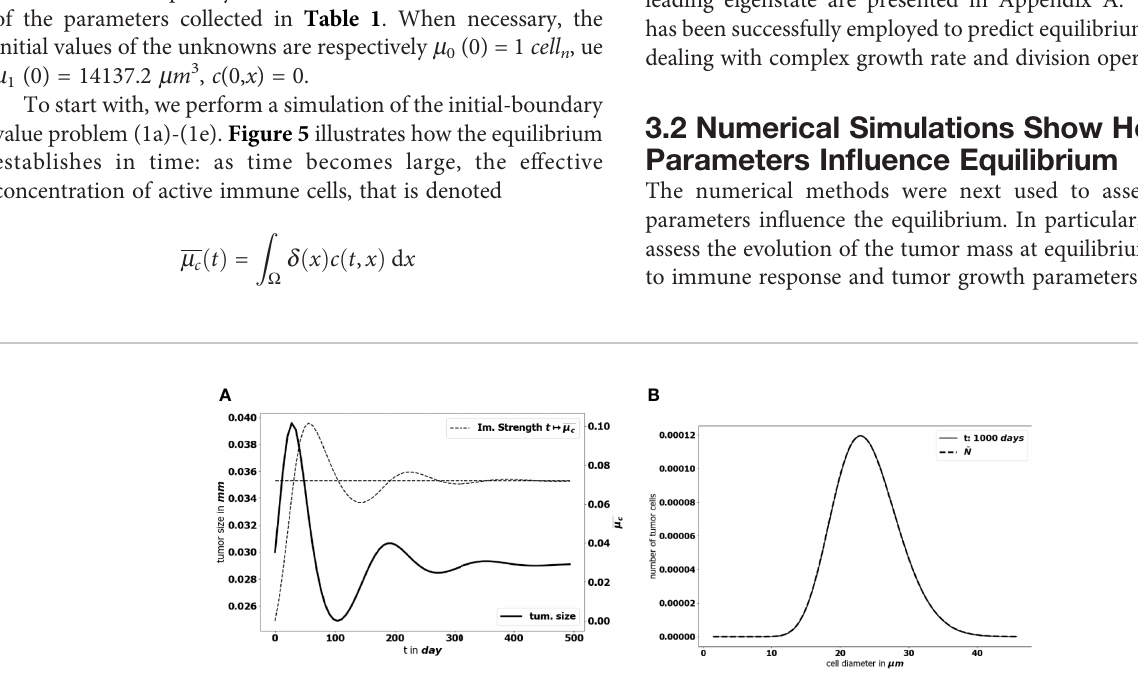
FIGURE 5 | (A) Time evolution of the diameter of the tumor (bold black line) and concentration of active immune cells (dotted gray line). The predicted asymptotic value for the latter is represented by the horizontal dotted line. (B) Comparison of the tumor cell-size distribution at t = 1000 days with the positive eigenstate of the cell division equation (x-axis: size of the tumor cells, y-axis: number of tumor cells at the fi nal time). For this simulation W ={ ∥ x ∥ ≤ 1 } , the data are given by the lower bound of the parameters collected in Table 1 and ( a , V , R )=( 0.072, 713.61, 1.74× 10 − 7